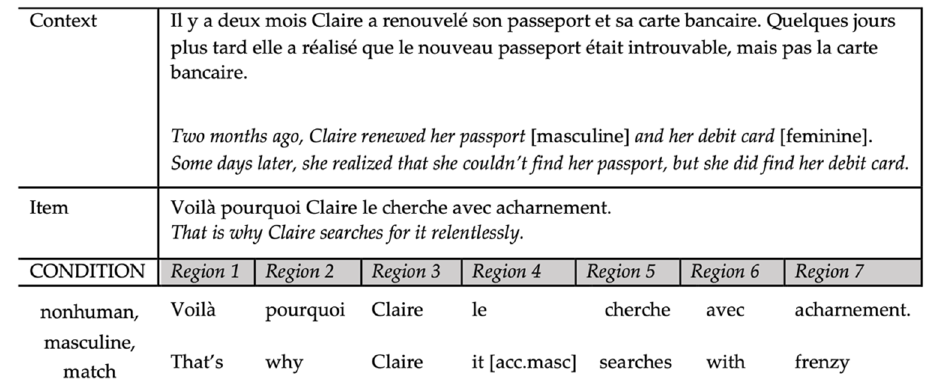
Figure 3. Schematization of an SPR item with English translations.